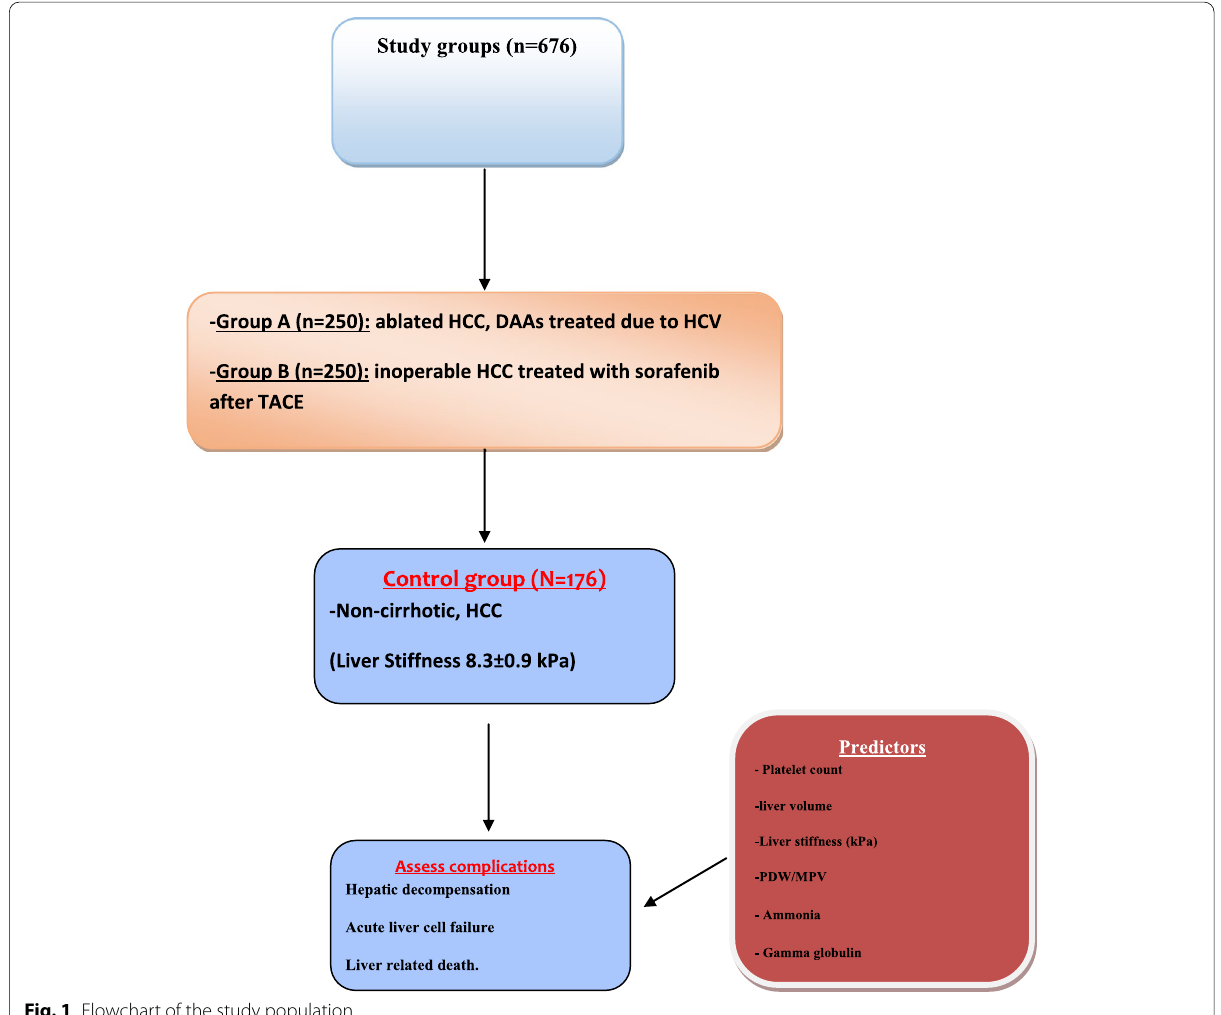
Fig. 1 Flowchart of the study